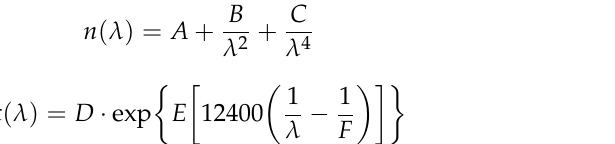
Figure 8. Transmission spectra of pure and Al-doped ZnO films on glass substrate at different Al contents.